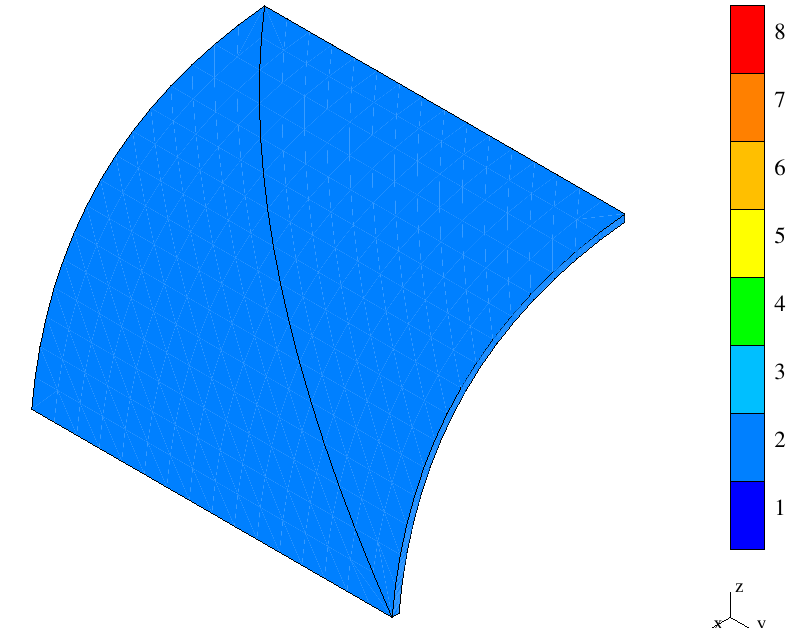
Figure 27. An octant of a membrane-dominated shell—initial mesh.